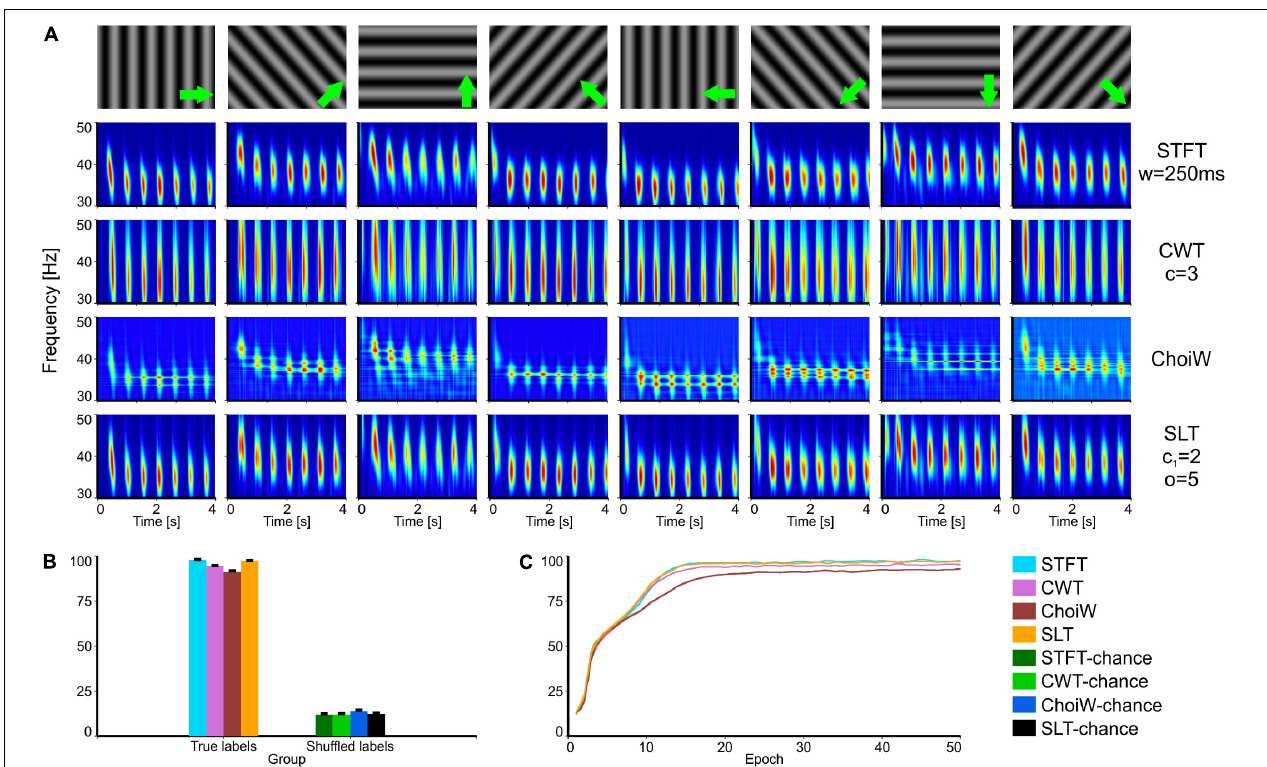
FIGURE 3 | Intracranial electrophysiology with SRCS visual stimulation protocol (SRCS-1). (A) Table of TFRs where each column corresponds to a particular grating direction (condition) and each row corresponds to one of the time-frequency analysis methods. (B) Average accuracy as measured on the validation set (100 network initializations and dataset splits), with original (true) and shuffled labels (for chance level estimation). (C) Learning curves on the validation set for the original labels group (chance level curves were omitted here but reside at ∼ 12.5%). Error bars are